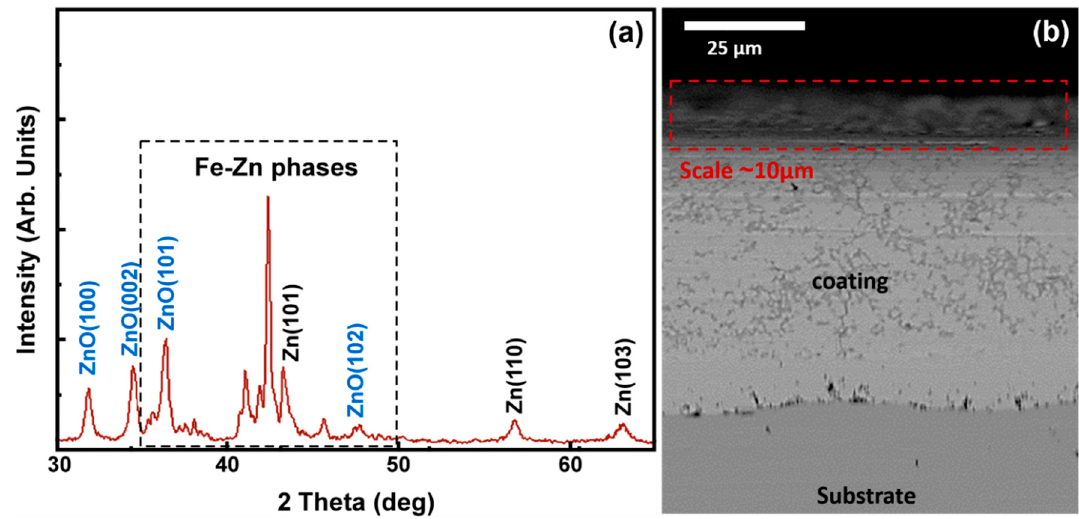
Figure 10. ( a ) GI-XRD pattern and ( b ) SEM micrograph of the oxidized hot-dip coating.